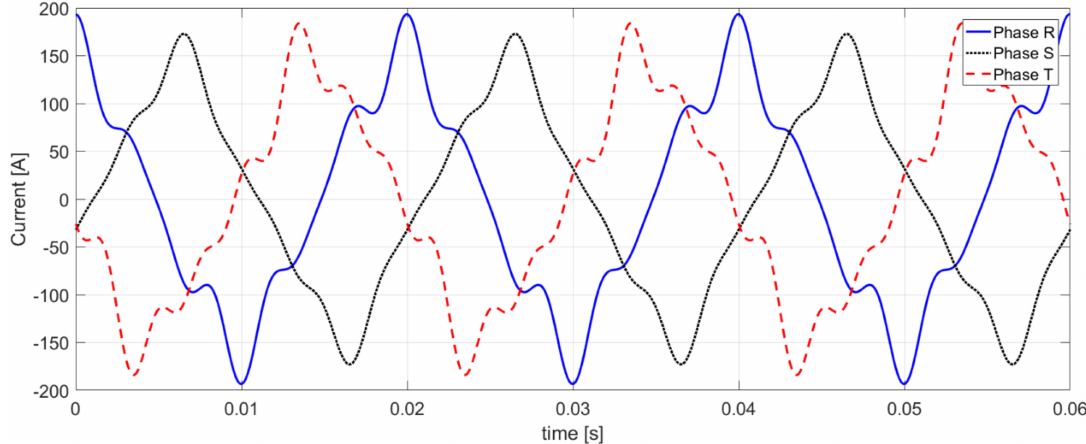
Figure 10. The waveform of three-phase nonsinusoidal active current in cross-section Z-Z’.